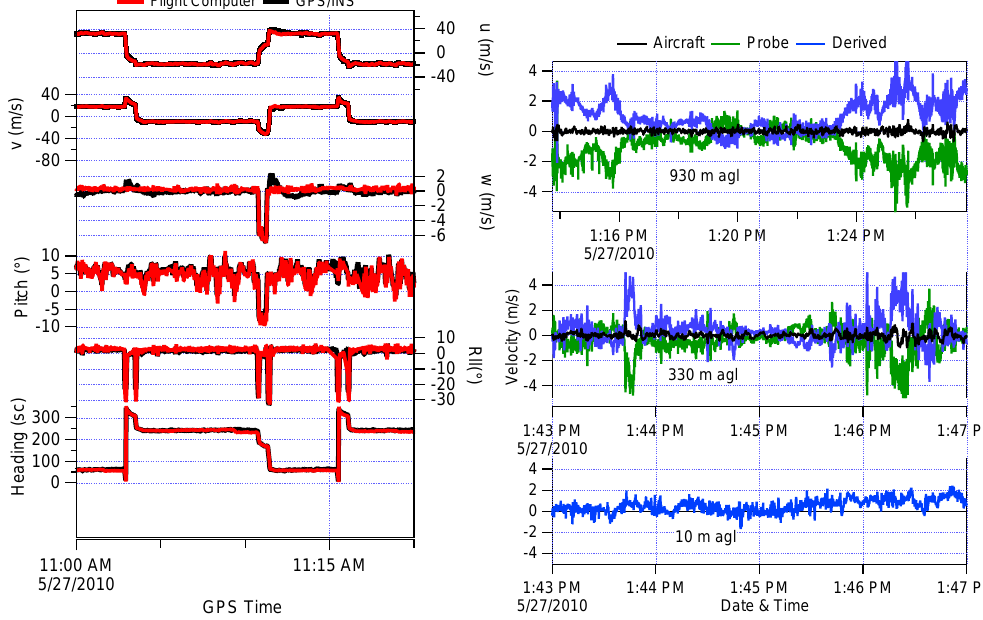
Fig. 7. (a) Time series comparison between on-board flight computer attitudes and ground velocities with those measured by the GPS/INS device during 20min of FT A resampled to 1Hz. (b) Eight minutes vertical velocities at two altitudes during FT B , showing 50Hz Airplane INS and gust probe data used to derive w . Tower data are also shown. High frequency fluctuations dominate the surface data. Thermal events are clearly seen at 330ma.g.l., and lower frequency signals are present above the boundary layer at 930ma.g.l. Gust probe data are inverted for